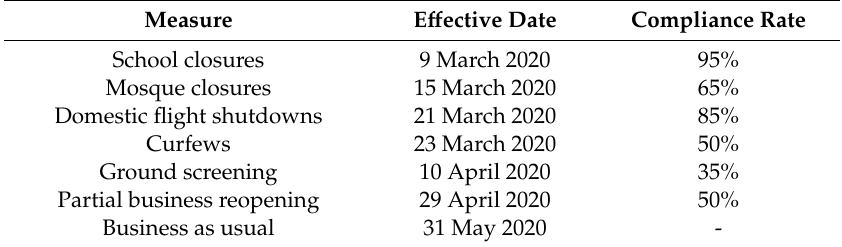
Table 4. Major control measures employed by the Saudi government during the COVID-19 pandemic. The e ff ective dates and assumed compliance rates are listed as assumed in our